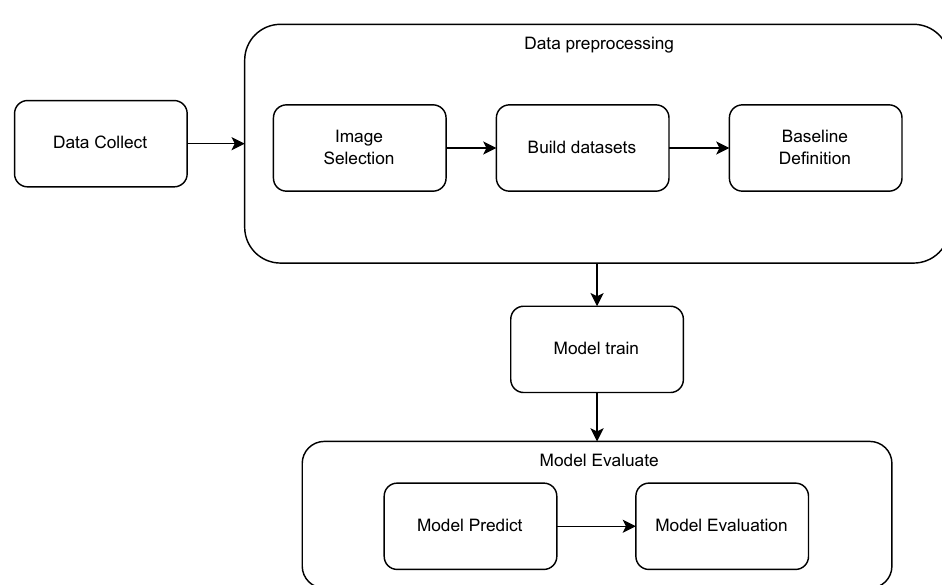
Figure 5. Flowchart of the system. The first step is data collection, followed by data preprocessing. After the data are preprocessed, they are used to train the ML models, and the final step is to evaluate the models, verify their quality, make predictions, and calculate the errors.